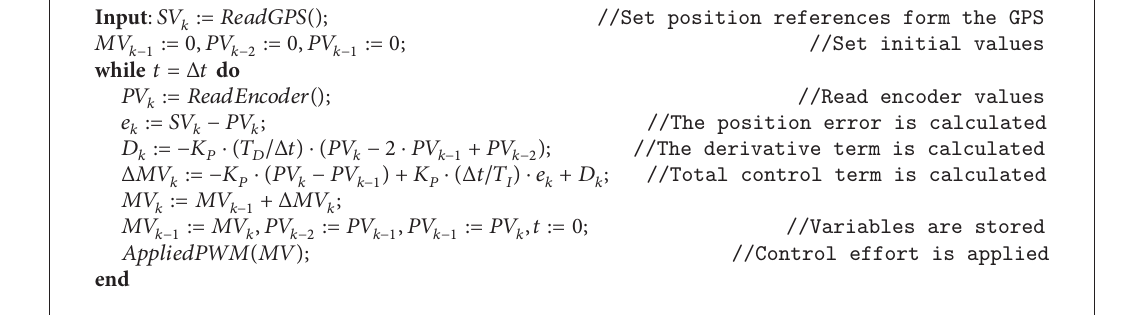
Algorithm 1: Advanced-PID position controller.